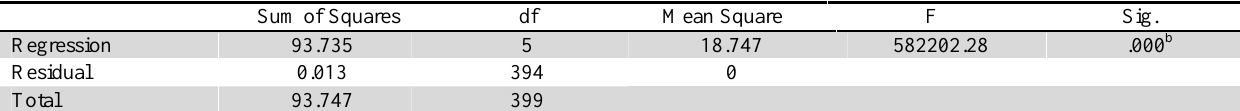
The results of ANOVA